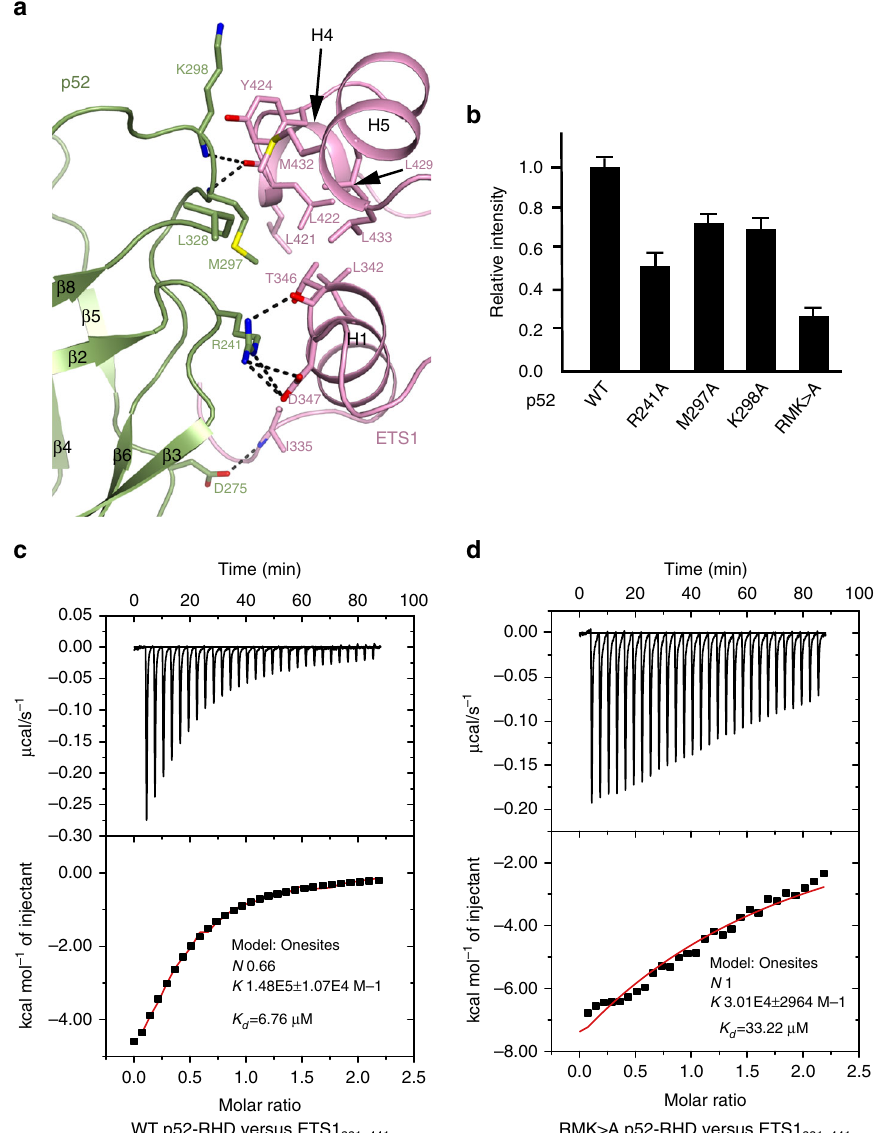
Fig. 2 The p52/EST1 interface. a A close-up view of the atomic interactions between p52-DSD and ETS1 332 – 437 . b FLAG pull-down assays of p52 and ETS1. The assays were quanti fi ed by band densitometry. Error bars, s.d. for triplicate experiments. c , d ITC titrations of ETS1 331 – 441 with p52-RHD and its RMK>A mutant. The upper panels show the binding isotherms and the lower panels show the integrated heat for each injection fi tted to a single-site